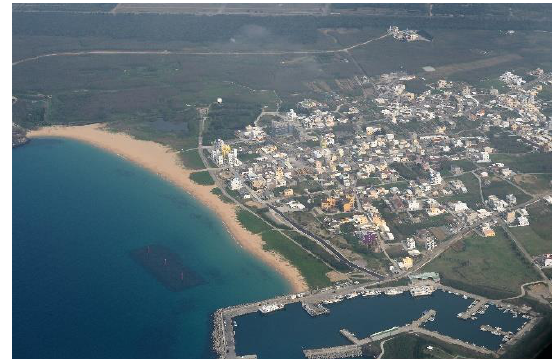
Figure 2. The Aerial Photography of Shanshui